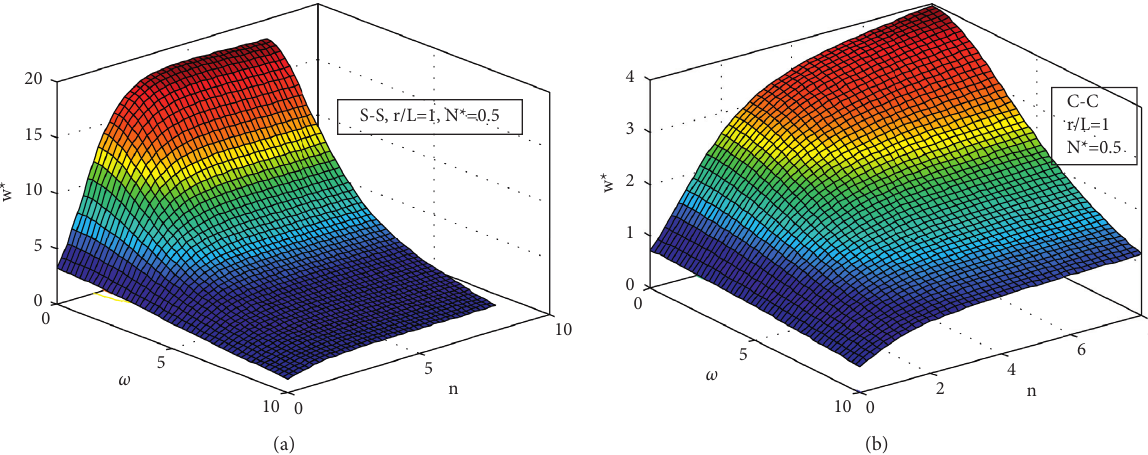
Figure 2: The nondimensional maximum deflection of the beam as a function of rotational speed, K ∗